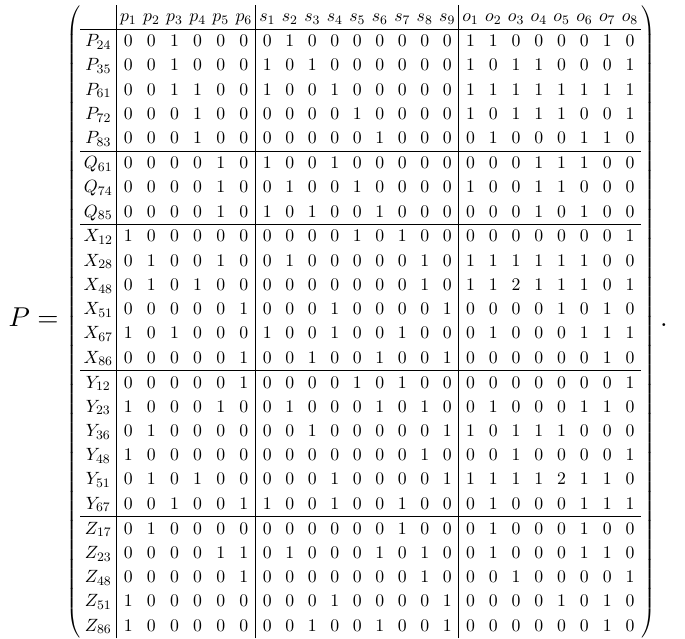
Table 26 . The generators in terms of bifundamental chiral fields for Model 6 (Part 2) . The P -matrix for Model 7